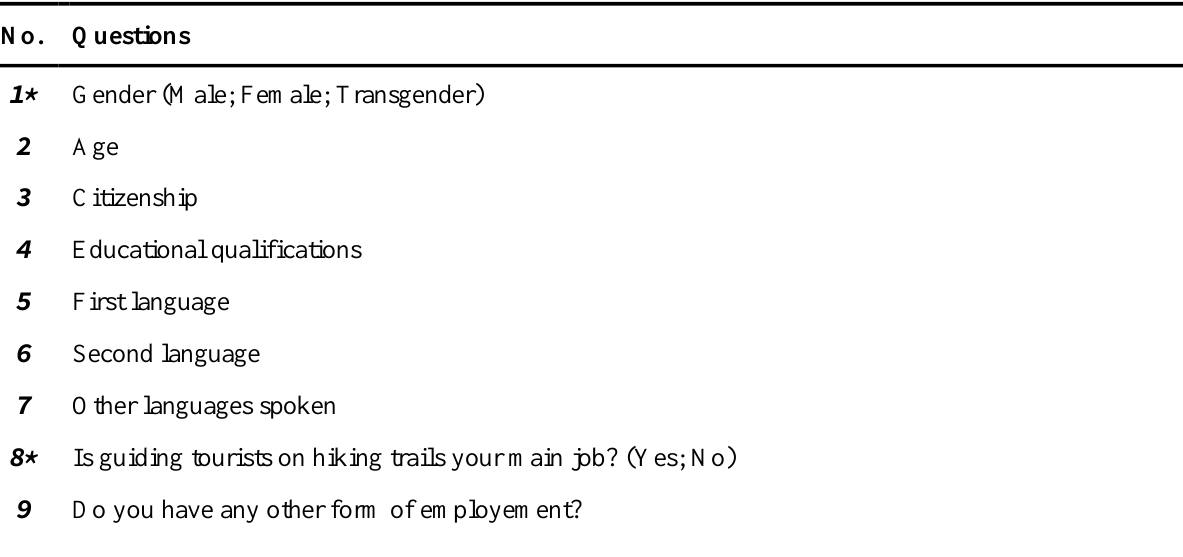
Table A1 Questions whose answers are categorical variables. Numbers (No.) with * identify close- ended questions, with the set of possible answers being reported in parentheses. Numbers without * are open-ended